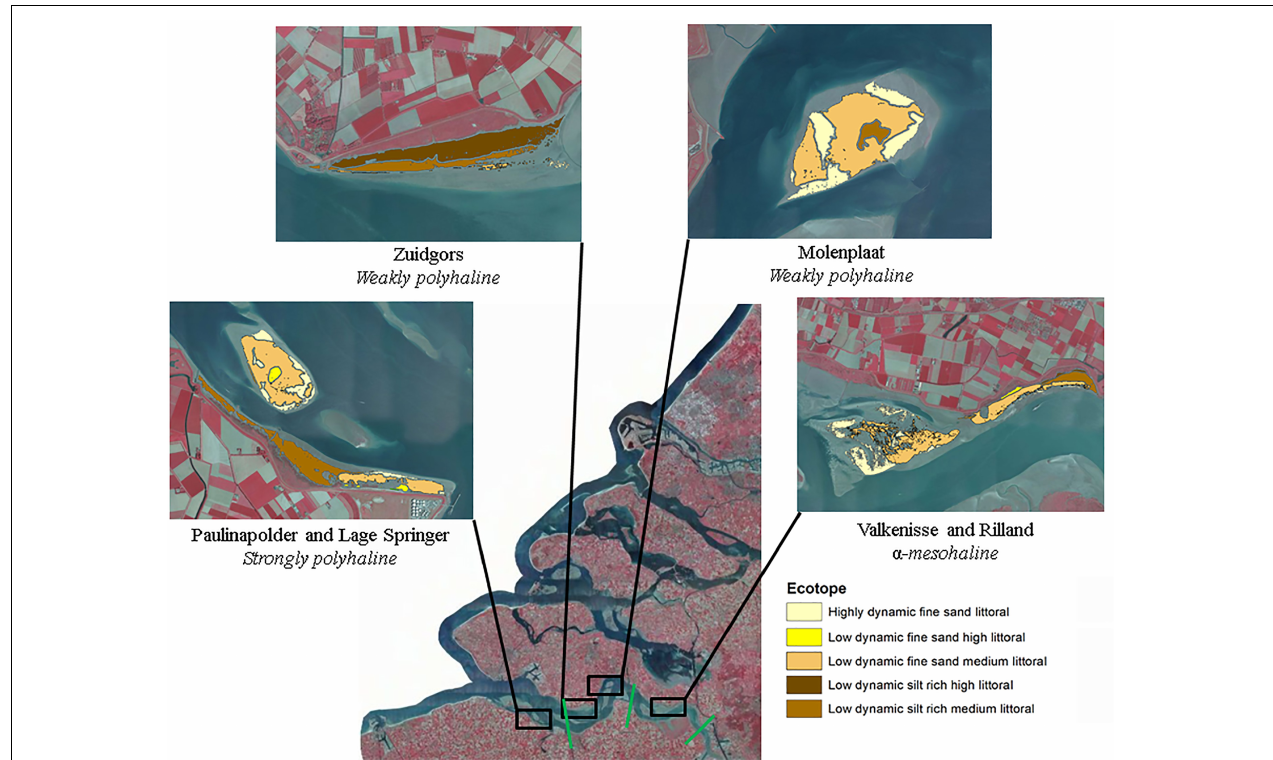
FIGURE 1 | Study sites. The boundaries between different salinity zones (strongly polyhaline, weakly polyhaline, and α -mesohaline) are indicated in green. The boundaries of the study areas are the outer boundaries of the displayed ecotopes and contain the part of the tidal flat that was emersed at all images (see ‘Data analyses’ for a detailed description of the followed procedure). Ecotope information was obtained from Rijkswaterstaat (2017). Source image: Esri, Aerial photograph of the Netherlands CIR - 25 cm resolution, 2017.